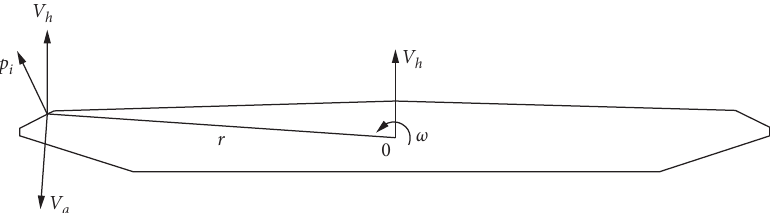
Figure 12: The schematic diagram of the motion equation for pressure taps.